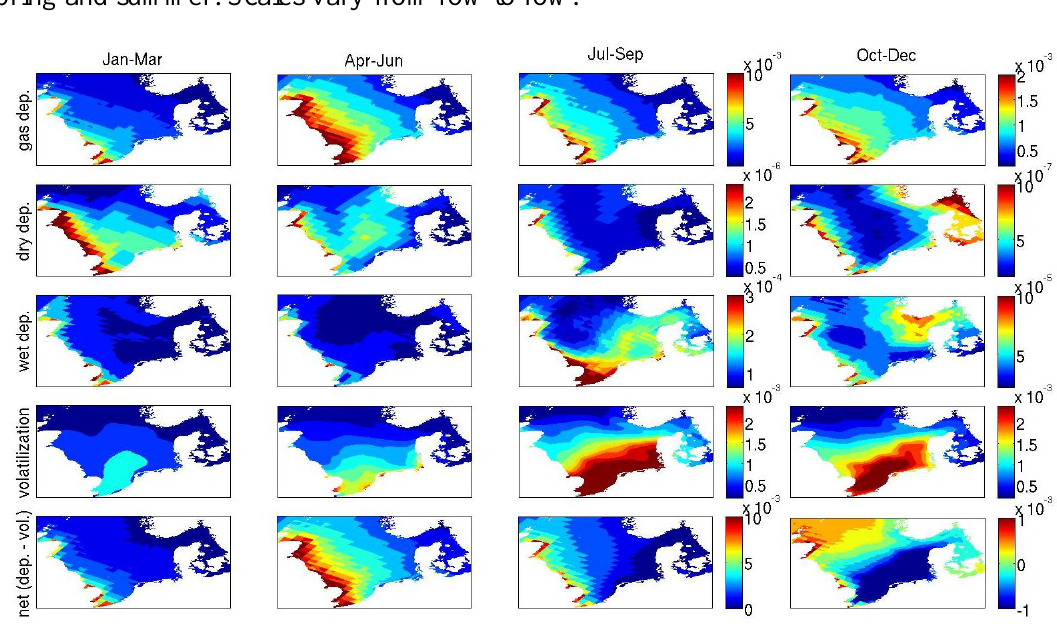
Figure 2. Distributions of quarterly (3 month) averaged rates of gas deposition ( top row ), dry deposition ( 2nd row ), wet deposition ( 3rd row ), volatilization ( 4th row ), and net air-sea exchange ( bottom row ) for γ-HCH in 1996. Rates are in (ng∙m −2 ∙s −1 ). Note: colorbar scales shown on 3rd column panels are used in connection with the left 3 panels. Note the change in scales for autumn (right figures), which are reduced relative to winter, spring and summer. Scales vary from row to